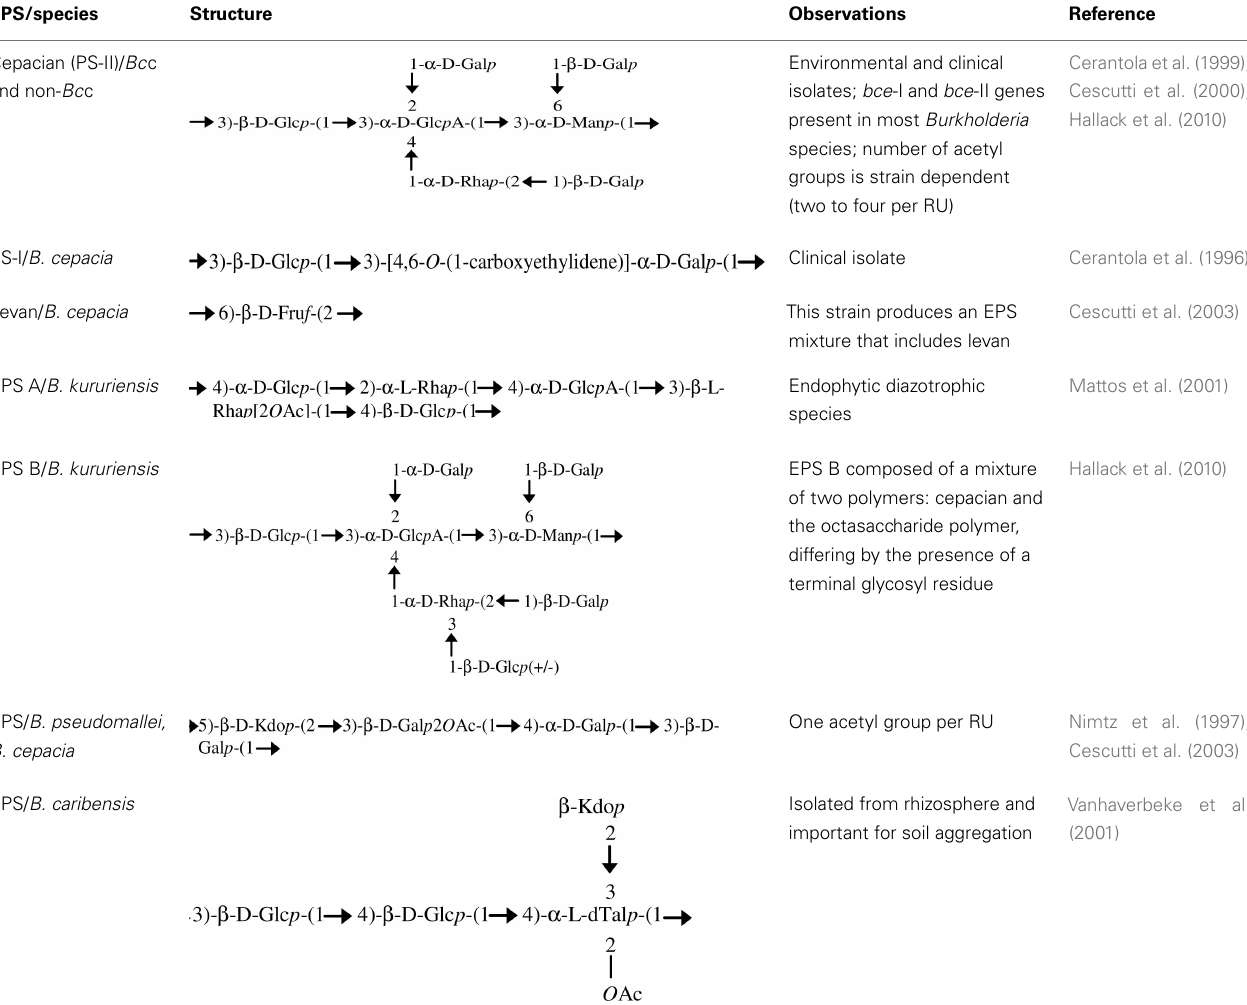
Table 1 | Structural formula of the exopolysaccharide repeated units described in the